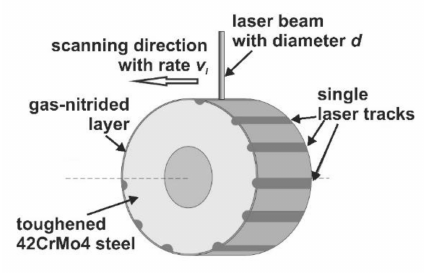
Figure 1. The technique of formation of single laser